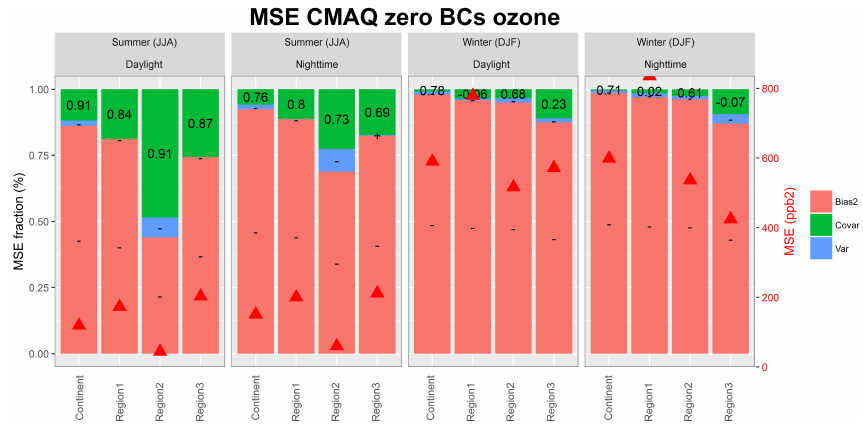
Figure 9. As in Fig. 6 for the hourly time series of the “zeroed boundary conditions”